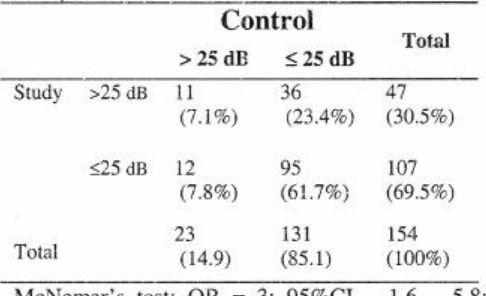
Table 4: Overall Impairment Of Hearing - Left Ear